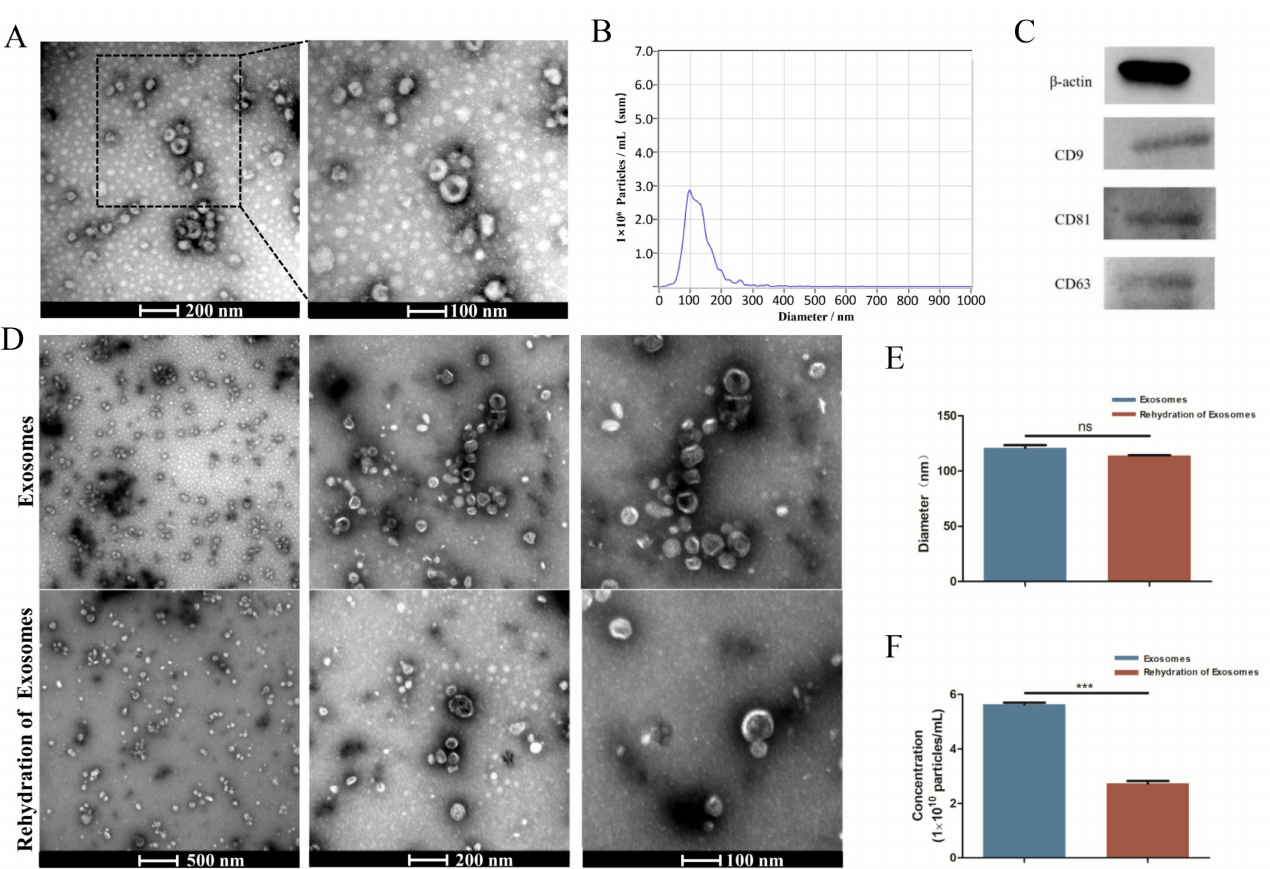
Figure 1. Characterization of HUCMSC-derived exosomes. ( A ) Morphology of exosomes detected by TEM. ( B ) Particle size distribution and concentration of exosomes observed by NTA. ( C ) Western blot analysis of the exosome surface markers. ( D ) Morphology of exosomes before lyophilization and after rehydration by TEM. ( E , F ) Size peak and concentration analysis of exosomes before lyophilization and after rehydration. ns p > 0.05, *** p <